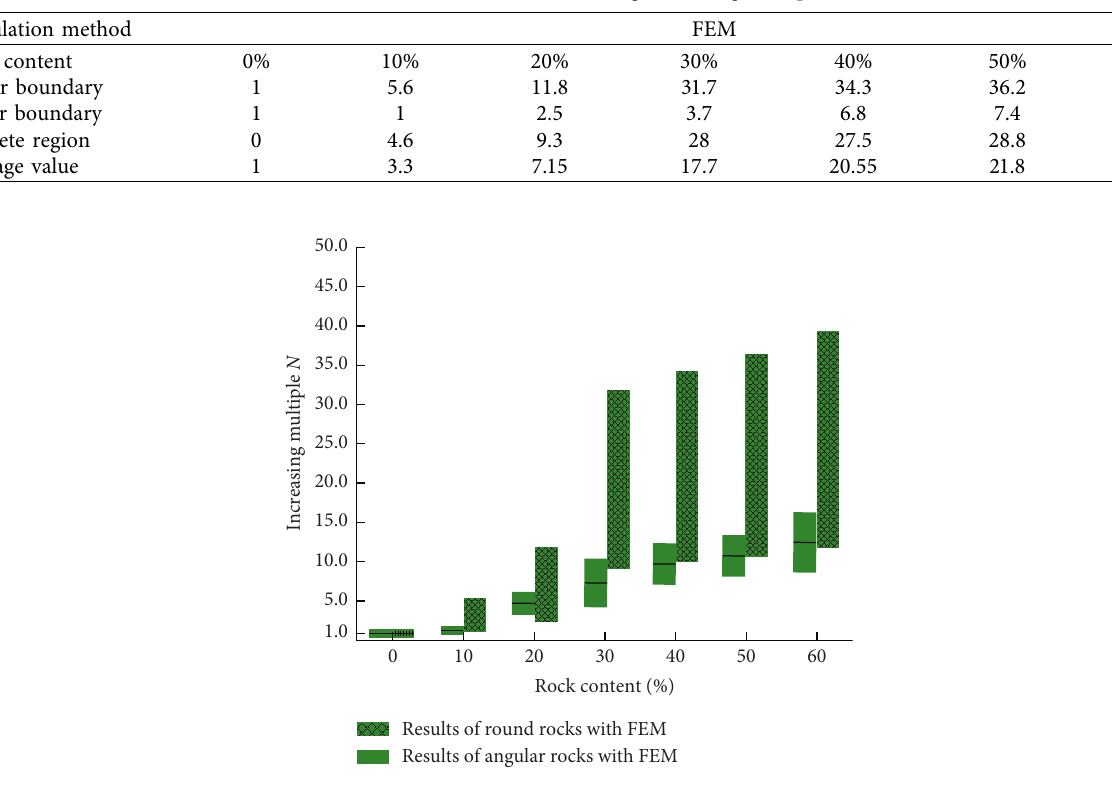
Figure 17: Results of ultimate loading increasing multiple N and rock content for different rock shapes. Table 5: FEM numerical